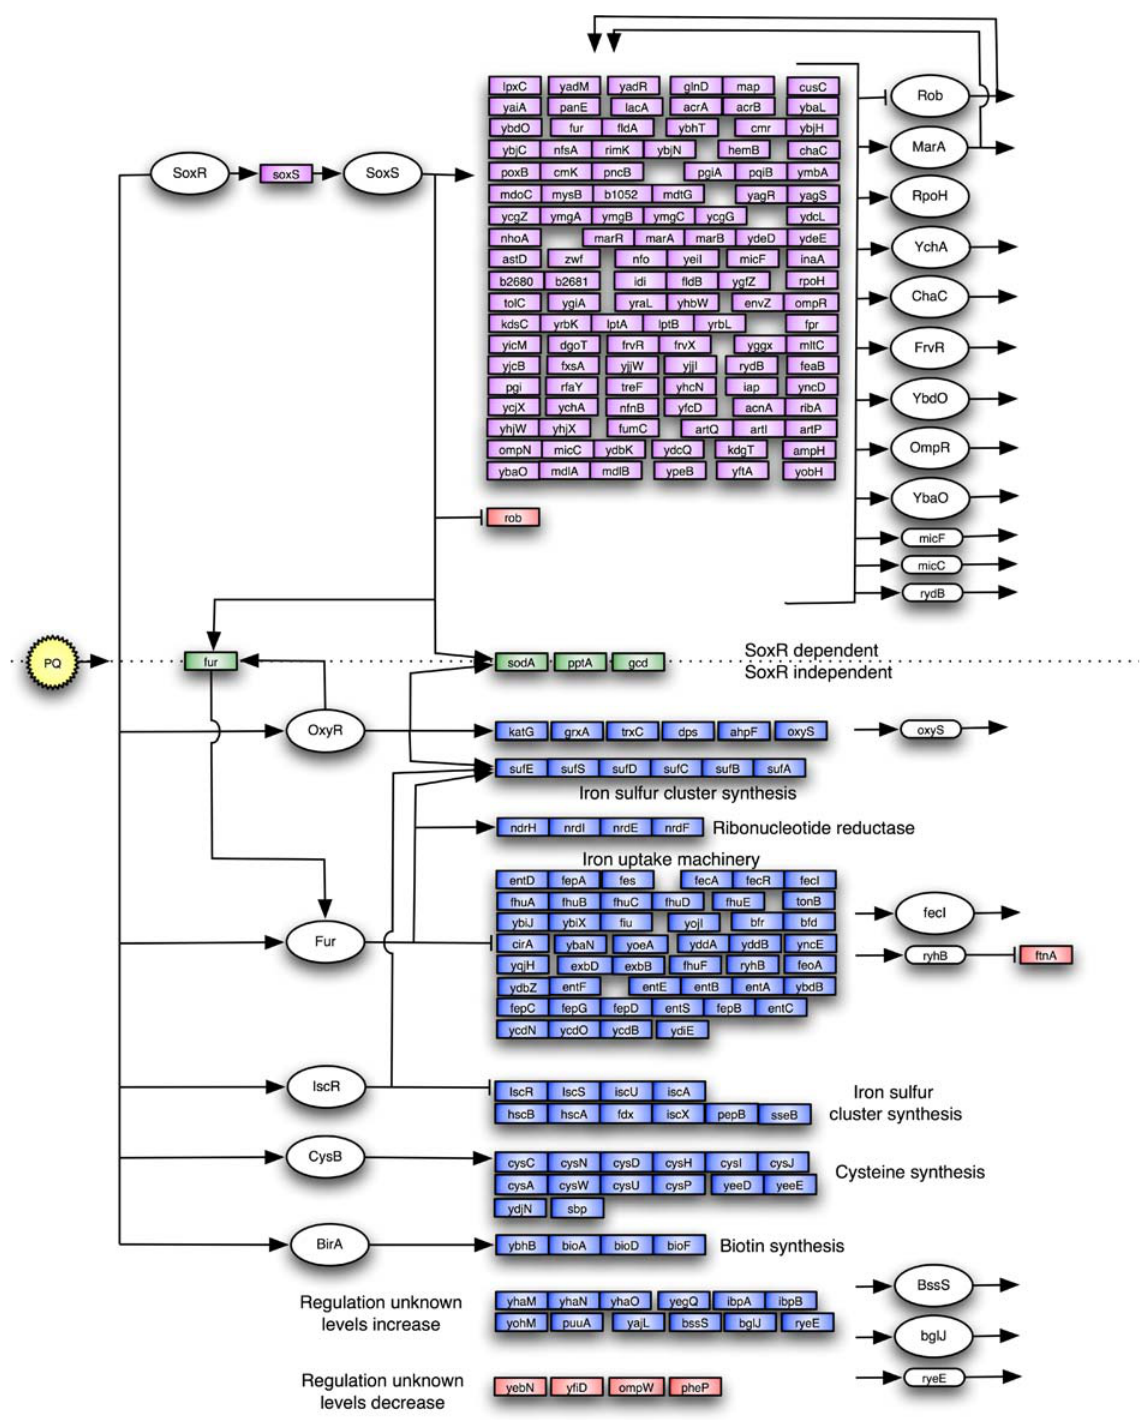
Figure 5. A model of the superoxide transcriptional response. This model summarizes the transcriptional response to paraquat, and consists of protein-coding genes and sRNAs present in the clusters 1–3 and 5–8 shown in Figure 3, along with their regulators and putative targets. It is a synthesis of our microarray results, interactions in RegulonDB, genome annotation and the primary literature related to the regulation of these primary paraquat responsive genes. Thus, it does not show other genes regulated by these transcription factors, nor does it include all regulatory factors that may govern these genes. Regulatory proteins are represented by ovals, sRNAs are represented by rounded rectangles and mRNAs are represented by boxes. SoxR-dependent transcripts that increase are shaded magenta, SoxR-independent transcripts are shaded blue, transcripts that are SoxR-dependent, but still have some residual paraquat response are shaded green, transcripts that decrease are shaded red. Regulatory proteins and sRNAs that appear on the right side of the figure are derived from transcripts present in the boxes. Boxes that are directly attached to each other represent chromosomally adjacent genes. Many of the transcripts are also connected as part of common protein complexes, metabolic pathways and in other biological processes. However, this level of biological detail could not be represented clearly in this model.